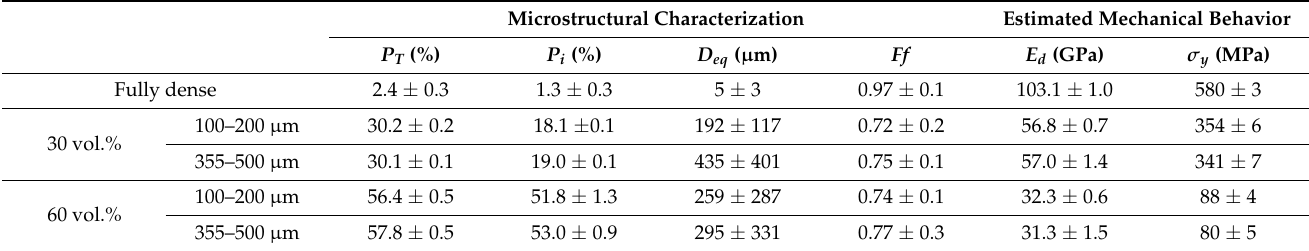
Table 1. Experimental porosity parameters and estimation of the mechanical